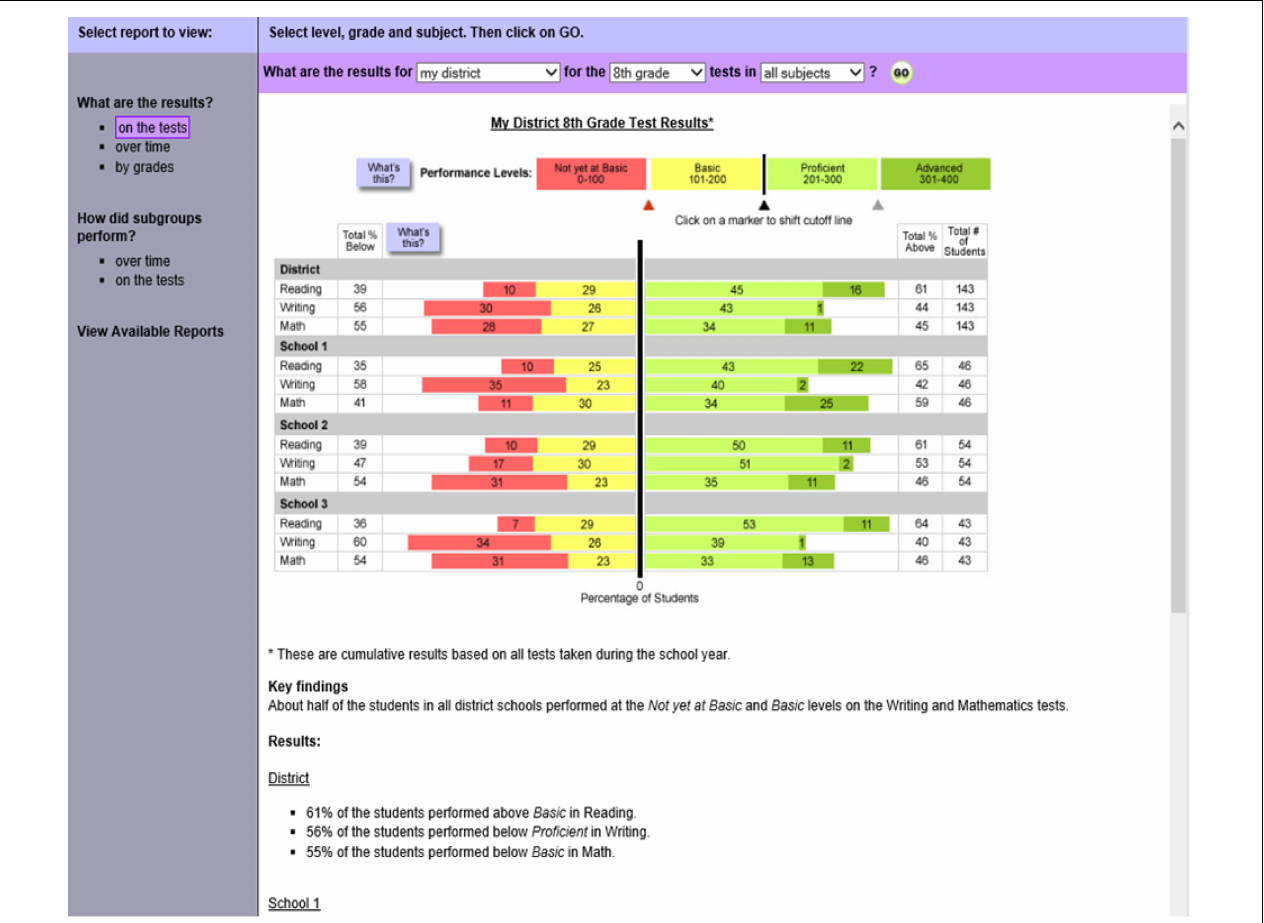
FIGURE 3 | Example of question-based reporting to alleviate DRIP (from Zapata-Rivera, 2020). Shows a way for teachers to easily drill-down into data by using a question-based method; rather than puzzle away at overwhelming amounts of data and tables, teachers would select from one of many focal questions that are critical to their instructional next steps and be able to see pre-canned visualizations that break down the data into understandable and actionable chunks to support instructional